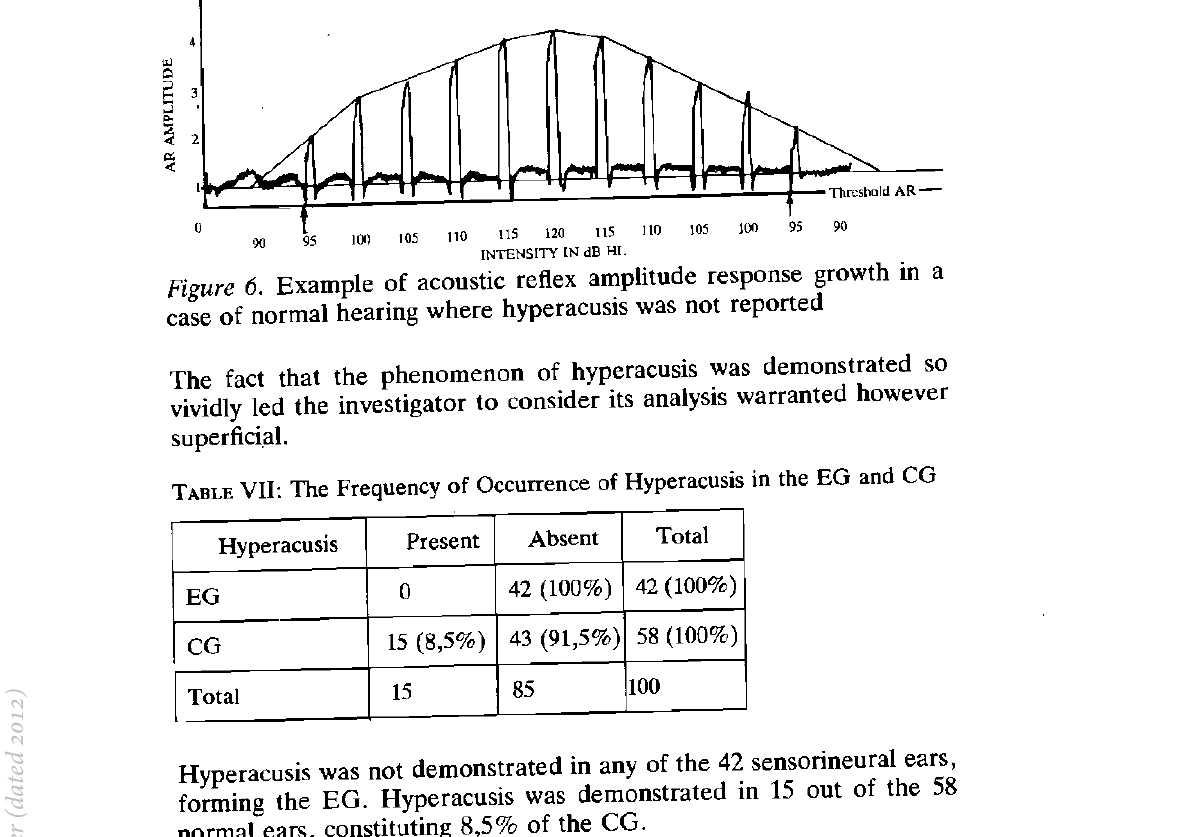
TABLE VIII: The Distribution of the ARGP's at Each Pure-Tone Frequency for Hyperacusis in Normally Hearing Ears ARGP's Peaked Rounded P/Rounded Flat R/Flat Total